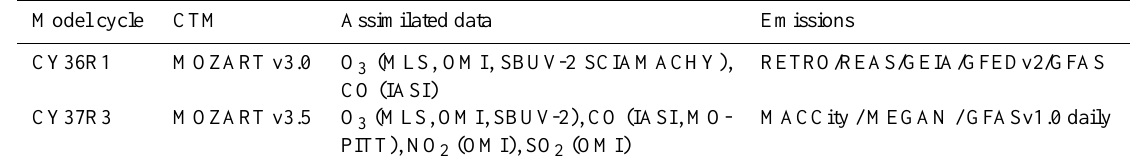
Table 2. Description of the set-up of the MACC_osuite between September 2009 and December 2012. Details on the assimilated data are provided in Table 1. A description of the emissions is given in Sect. “Emission inventories and assimilated data sets” in the